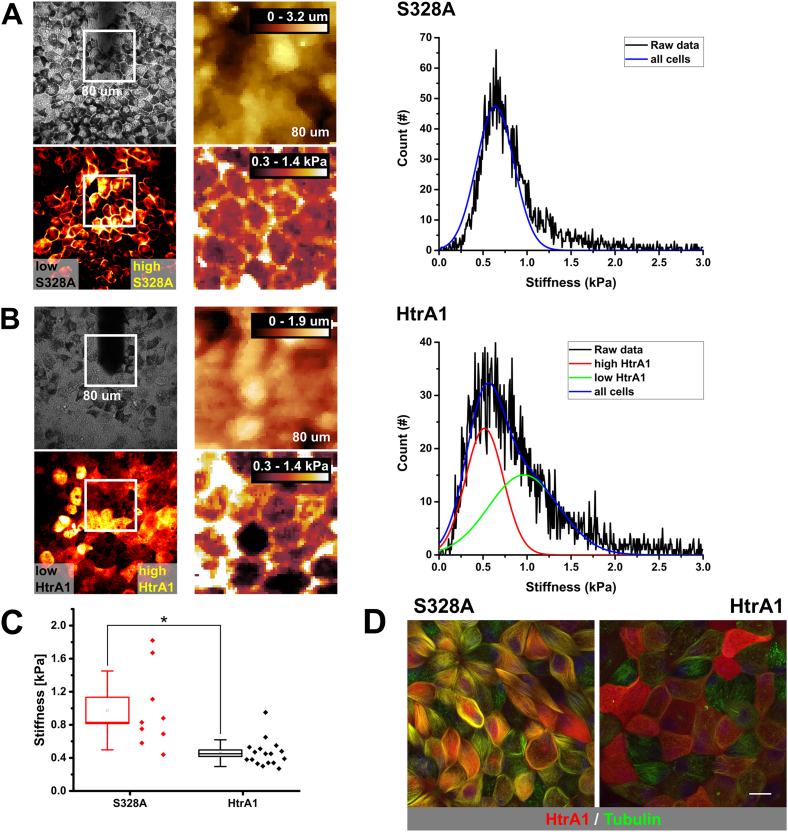
The nanomechanical fingerprint of RPE cells overexpressing HrA1 and S328A variant. (A/B, left panels) The cell viability and position of the AFM probe is monitored in the brightfield signal for each experiment. Live-Fluorescence imaging allowed for identifying the overexpressing cells (white insert). AFM topography and stiffness data belonging to the measurements (white insert). (A, right panel) Stiffness data, S328A variant cells exhibit similar properties when compared to the neighboring negative cells. (B, right panel) Stiffness data, HtrA1 overexpressing cells showed a 2-fold decrease for RPEs overexpressing HtrA1 (red line) when compared to cells having a low HtrA1 content (green line). (C) Quantitative stiffness analysis over multiple measurements. N = 9 maps (n = 92 cells) for S328A and N = 17 maps (n = 168 cells) for HtrA1, *p < 0.05. (D) Live cell imaging Halotag TMR ligand for HtrA1 (red), SiR-Tubulin (green) and Hoechst (blue). Scale bar, 20 μm.